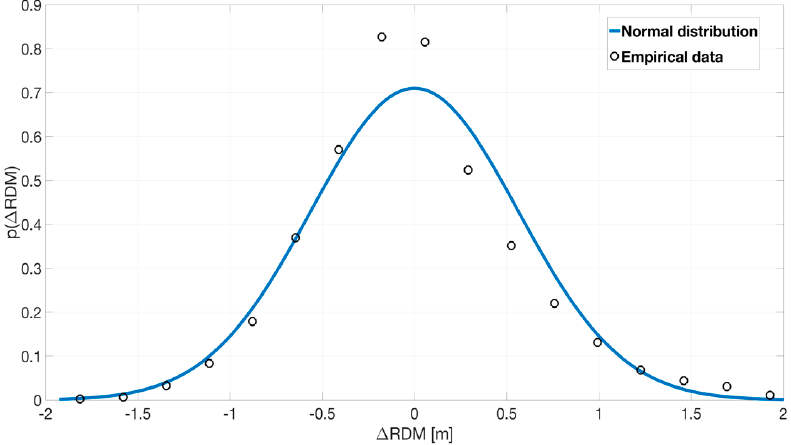
Figure 3. An example of an empirical error probability density function (PDF) around the average value with a fitted normal distribution for one of the measurement scenarios.